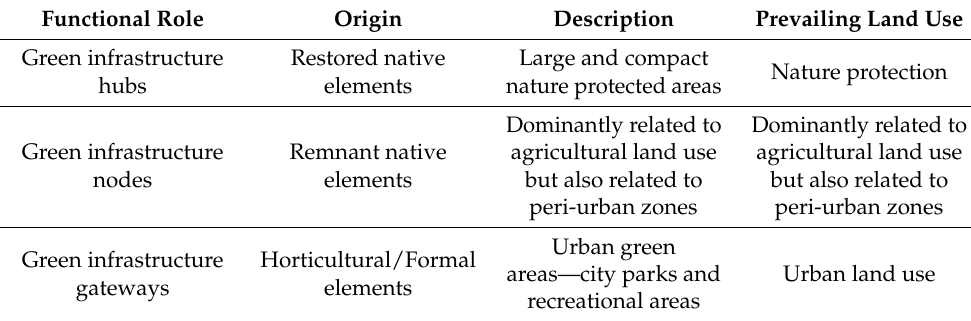
Table 1. Green infrastructure elements.